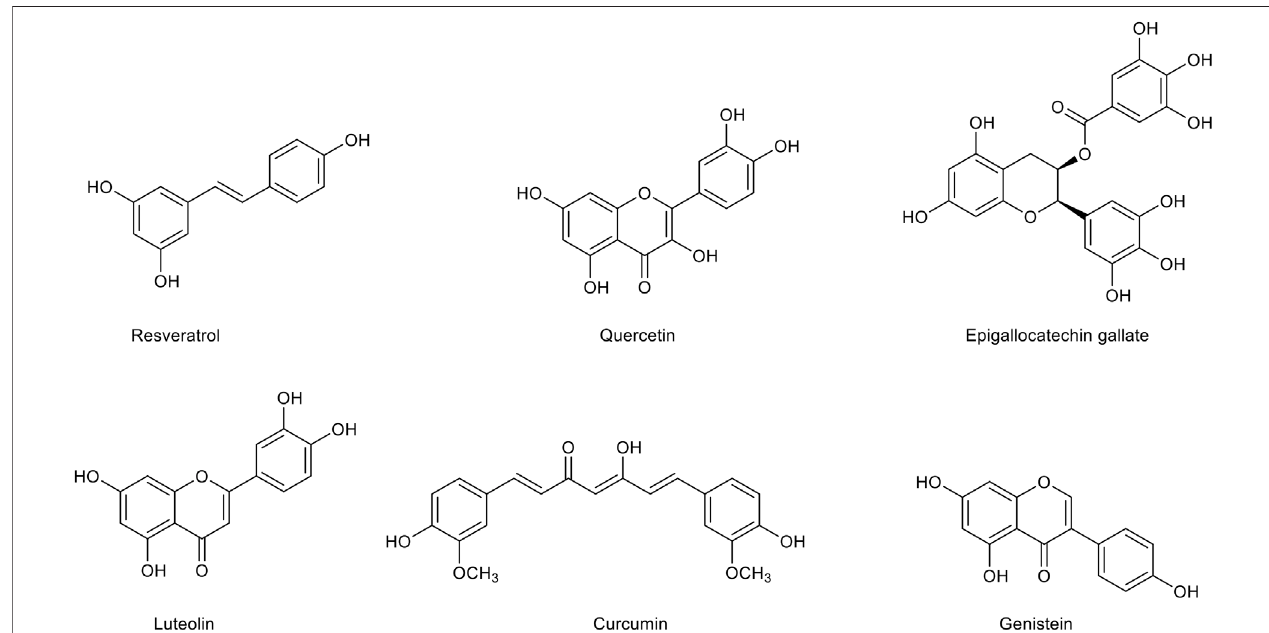
FIGURE 3 | Chemical structures of the main polyphenolic compounds with a therapeutic potential for Alzheimer ’ s disease